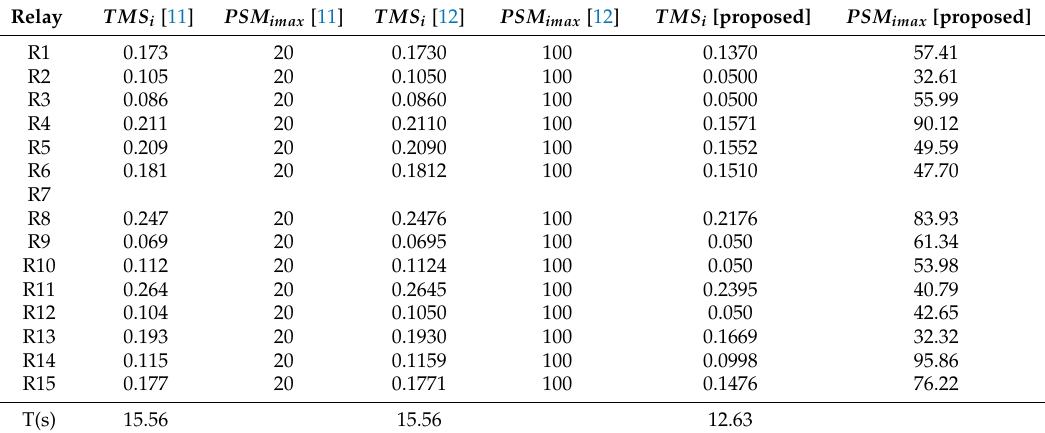
Table 9. Coordination parameters for OM4.